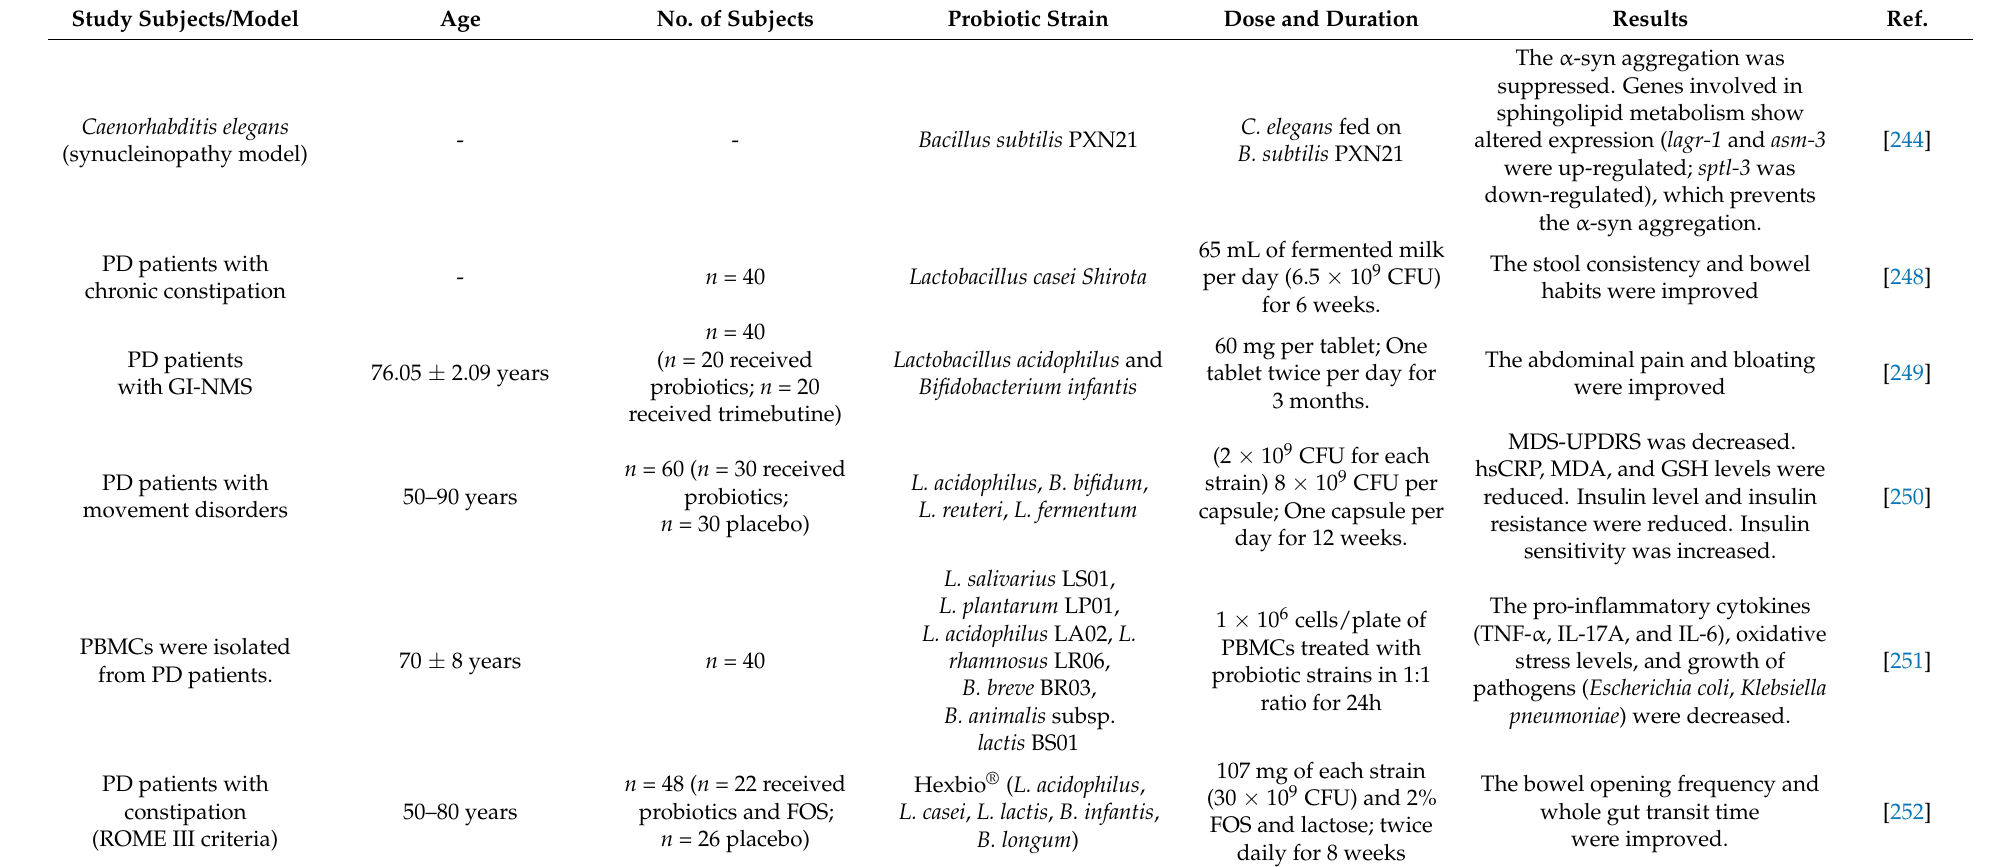
Table 1. The impact of probiotic supplementation on PD patients and model